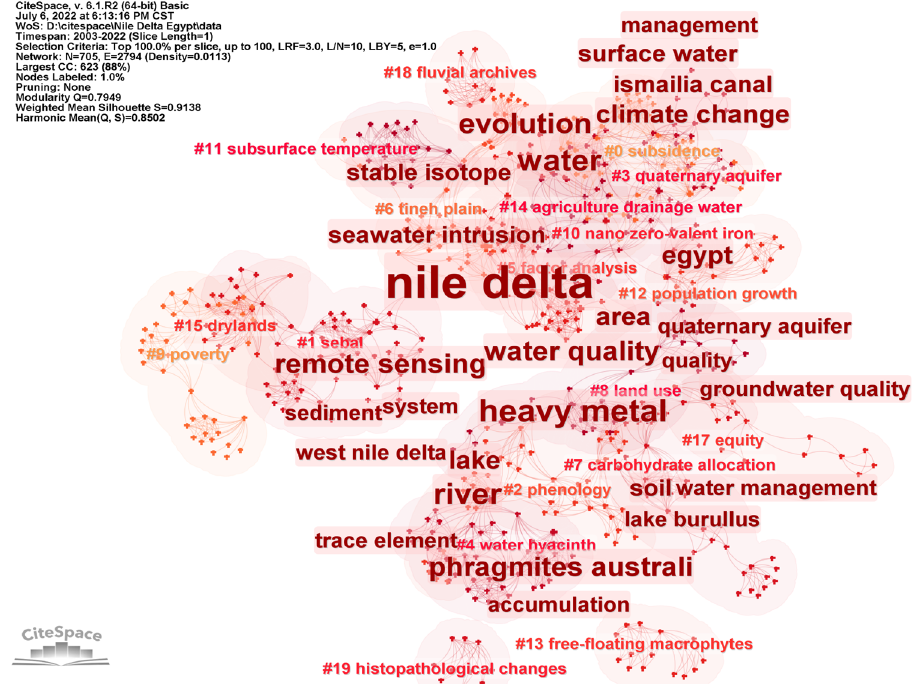
Fig. 6 Keywords and knowledge clusters of Nile Delta of Egypt literatures in WoS database (2003 –